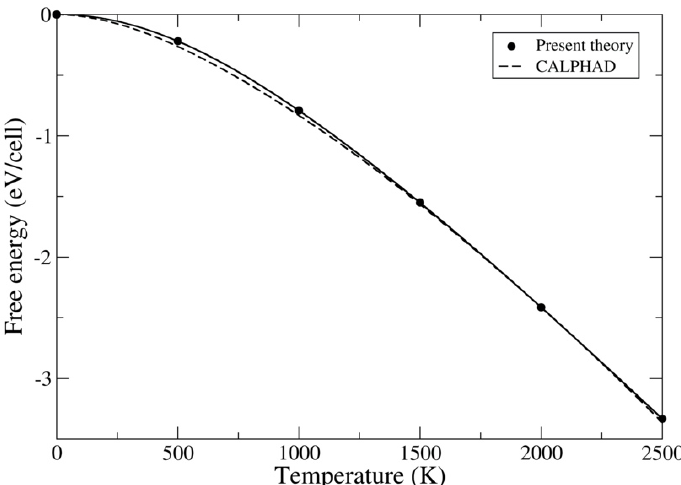
Figure 5. Free energy for UC from present theory together with results from our CALPHAD calcu- lation (dashed line). Solid symbols show our present theory, and the solid line is guide for the eye only.